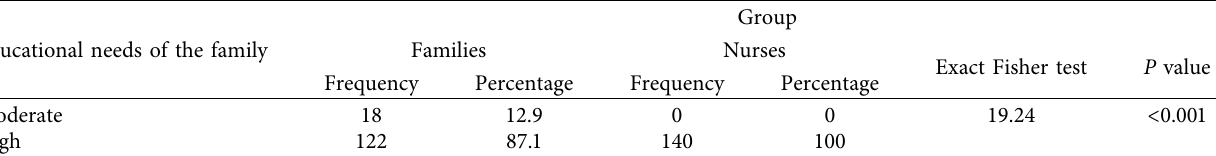
Table 2: Comparison of the severity of the educational needs of the patients discharged from the intensive care units from the viewpoint of nurses and